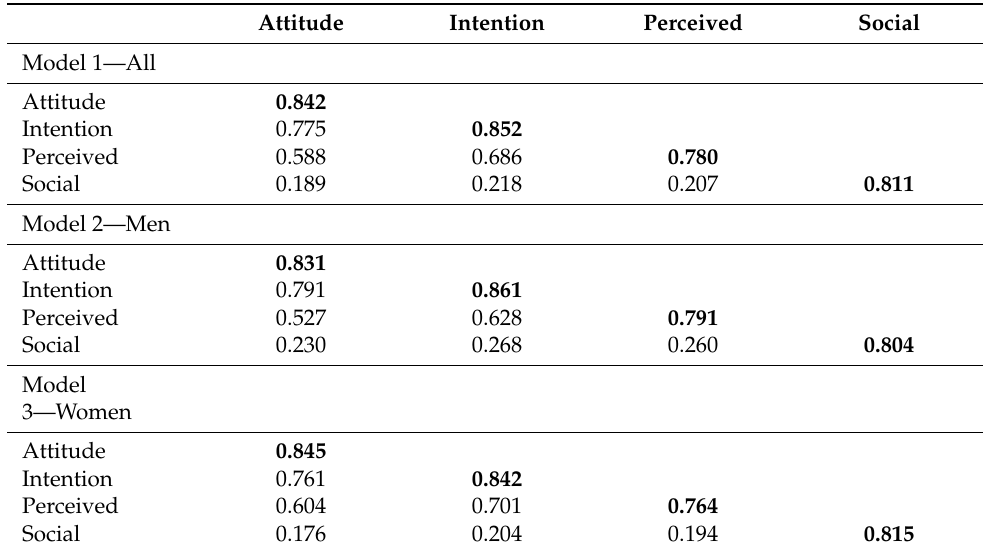
Table 4. Discriminant validity of the model according to the Fornell–Larcker